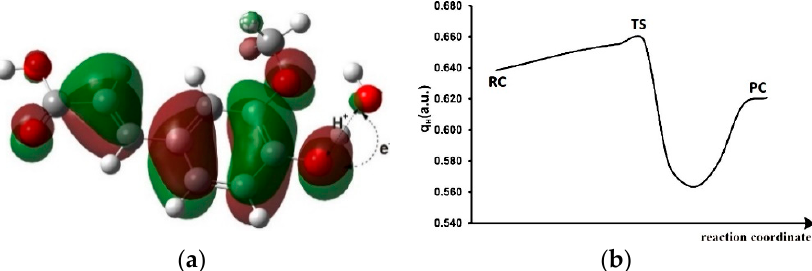
Figure 2. ( a ) TS structure of the reaction of the 4-OH group of FA with the • OH radical accompanied by the corresponding SOMO. ( b ) The change of charge on transferring the H-atom along the reaction coordinate for the reaction between FA and • OH radical.